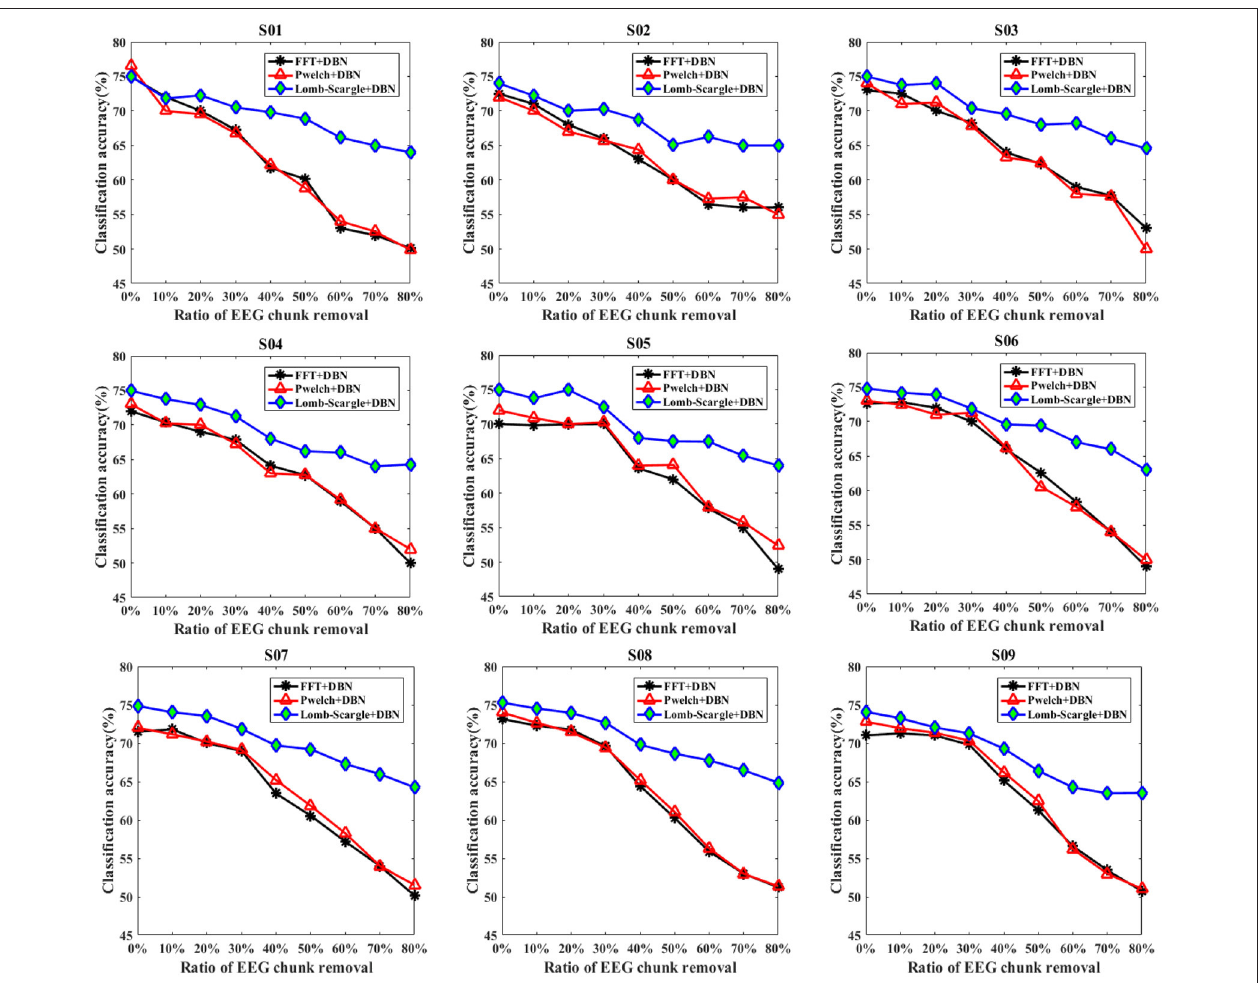
FIGURE 6 | The classification results of intact EEG and incomplete EEG with various ratios of data chunk removal (from 10 to 80% with a step of 10%), for the nine subjects (from S01 to S09). Three spectral feature extraction methods were used for comparison: the black lines, red lines and blue lines represent the accuracy of DBN with FFT, Welch and Lomb-Scargle feature extraction,